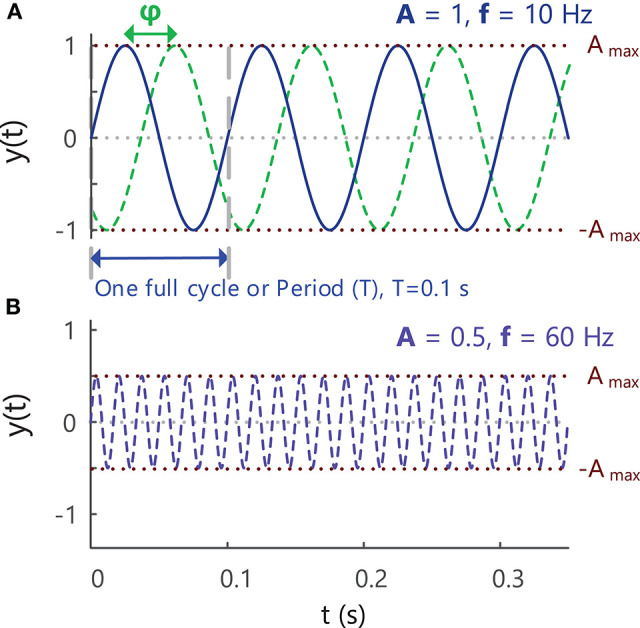
(A) A sine wave with an amplitude of 1, frequency of 10 Hz and phase of zero, showing the variation in the signal over time. A second sine wave with the same amplitude and frequency but different phase (–π/2 = −90°) is indicated with the green dashed lines. As the value of a sinusoidal signal at any point in time is based on circular motion, the phase of a signal is expressed as an angle in radians or degrees (start of period = 0°, end of period = 360° or 2π radians). (B) A sine wave with an amplitude of 0.5, frequency of 60 Hz and phase of zero. See Example (ii) in Tutorial Code.